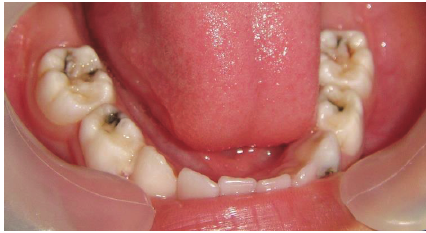
Figure 7: Postoperative photograph (Case 2